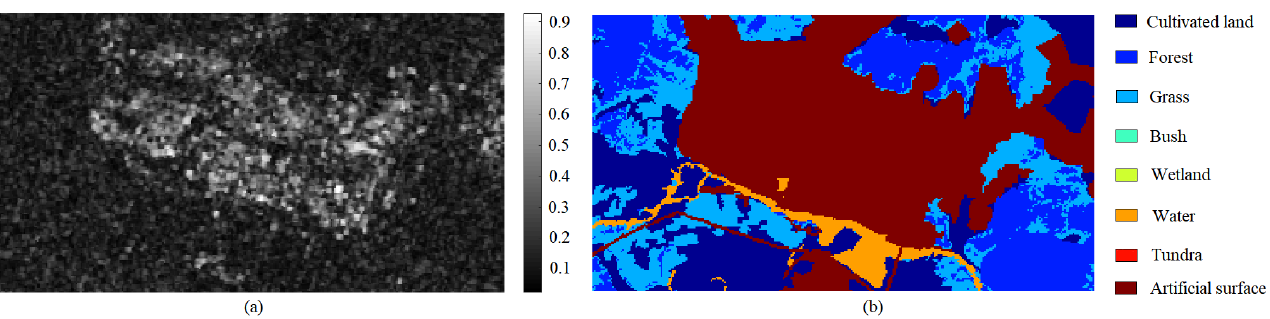
Figure 15. Analysis of incoherence caused by land cover change (the location is 124°03 ′ ~124°11 ′ E and 50°23 ′ ~50°27 ′ N): ( a ) the cut coherence coefficient diagram; ( b ) a classification map of the corresponding area.